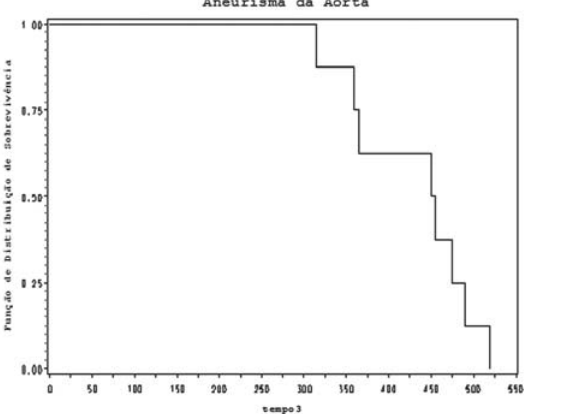
Fig. 4 - Sobrevivência por Tipo: Aneurisma da Aorta - tempo 3: T3 -Tempo da Presença do Doente na Sala de Operação